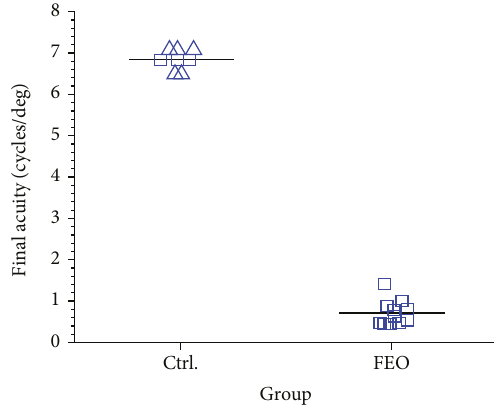
Figure 8: The open square symbols show a comparison of the fi nal acuity achieved by the deprived eye of the 3 animals in the control group (Ctrl) following darkness with that achieved by the deprived eye in the 11 animals that had the fellow eye occluded for various short periods of time after they were removed from the darkroom. The triangle symbols for the control group display the results from animals reared in an identical fashion in two prior studies ([28]; C151, C152, C155, and C157) and [29];